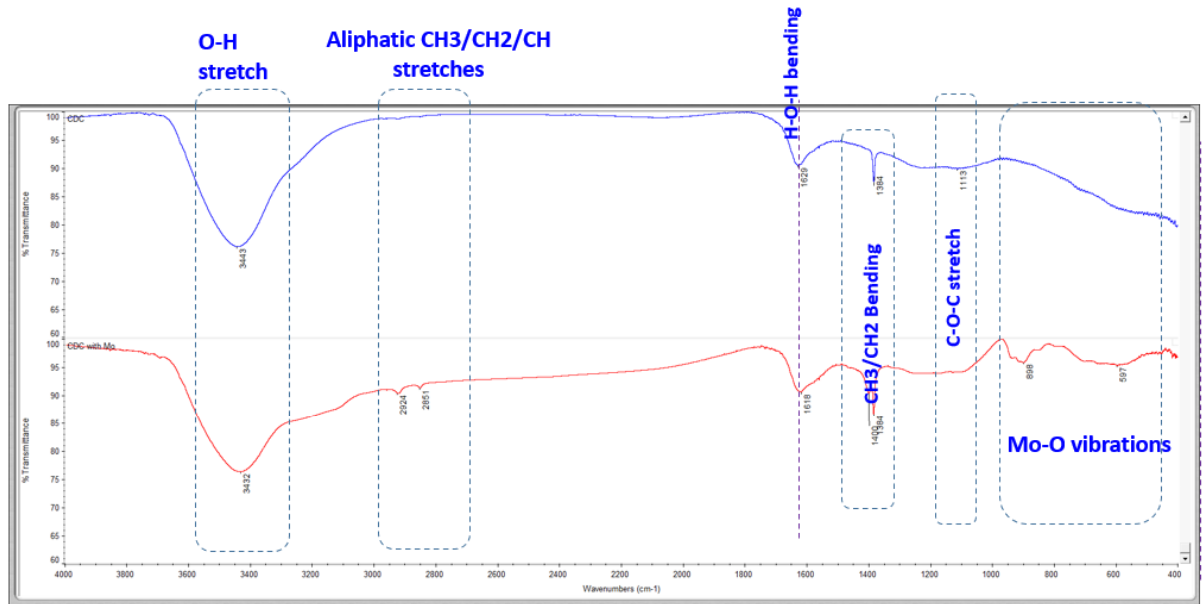
Figure 8. FTIR spectra of CDC samples before (blue line) and after (red line) Mo adsorption.